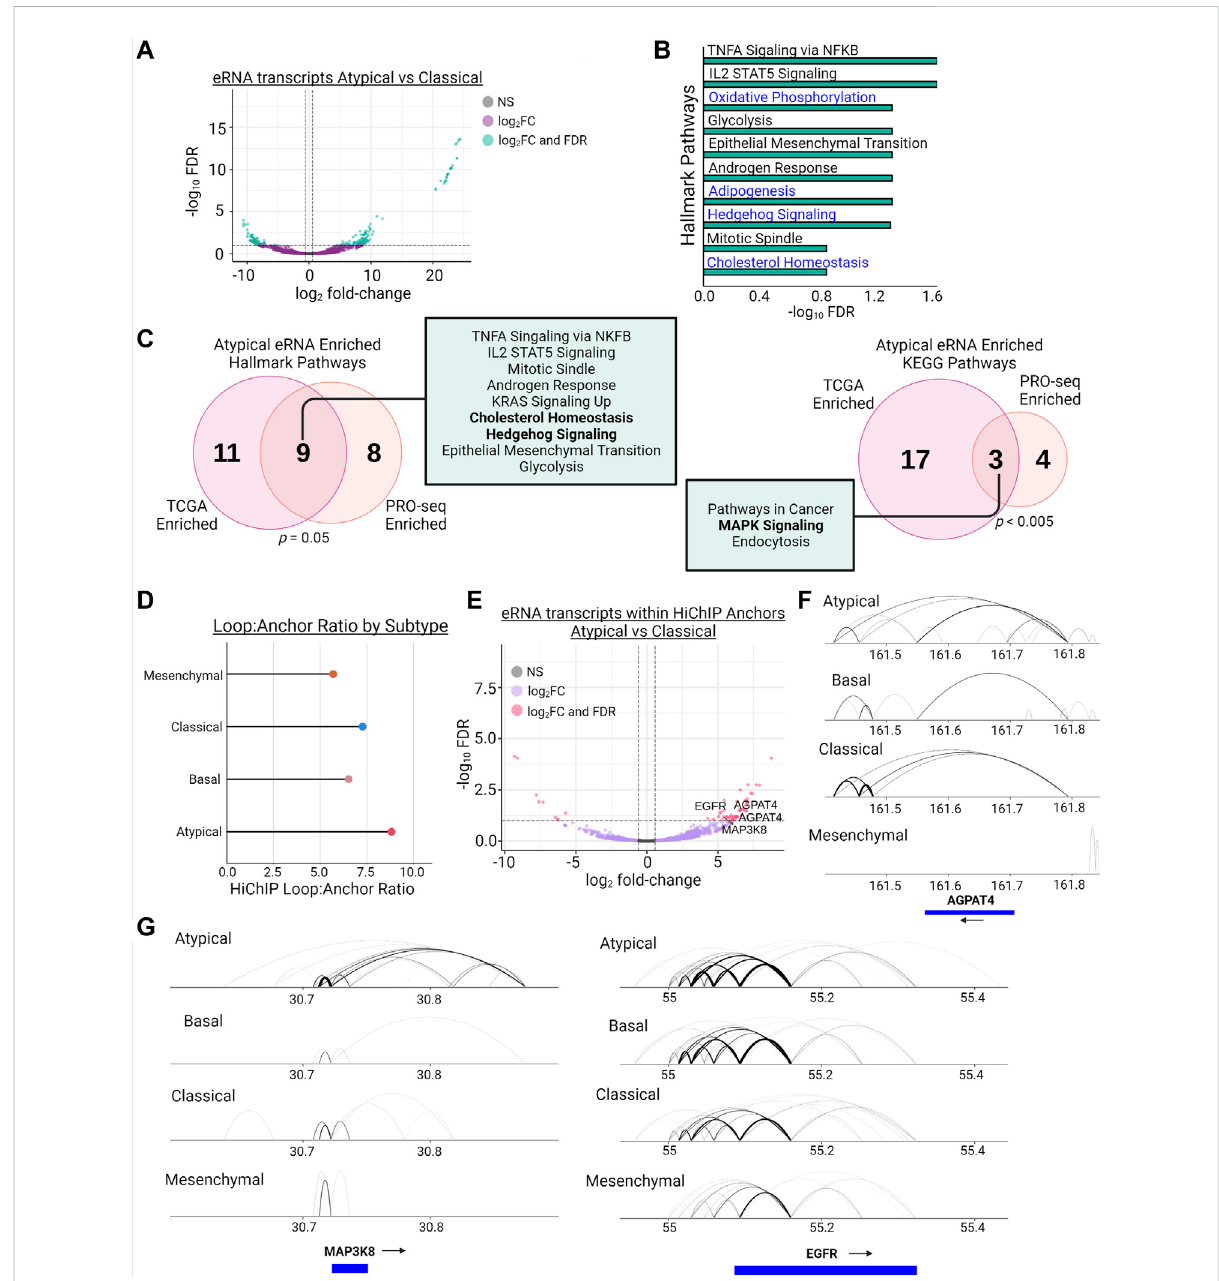
FIGURE 4 Enhancers of MAPK signaling, WNT signaling, and Cholesterol Homeostasis genes display increased eRNA transcription and enhancer- promoter looping in Atypical HNSCC. (A) Differential transcription (|log 2 fold-change| > 1.5 & FDR < 0.1) of eRNAs between the Atypical and Classical subtypes as measured by PRO-seq (green dots meet fold-change and FDR thresholds, purple dots meet fold-change threshold only). (B) Hallmark pathwayenrichmentanalysisofgeneslinkedtoeRNAswithsigni fi cantlyincreasedtranscriptionfrom (A) ;pathwaysinbluehavebeenpreviously associated with BET inhibitor resistance. (C) Overlap of hallmark (left) and KEGG (right) pathway enrichment results between PRO-seq-determined signi fi cantly enriched eRNAs from (A) and (B) and TCGA-measured differentially expressed eRNAs between Atypical and non-Atypical samples; p valuesrepresenthypergeometrictestsofgenesetenrichmentresultoverlaps;boldedtermsrepresentsharedpathwaysassociatedwithBETinhibitor resistance. (D) Lollipop plot demonstrating the loop count:anchor count ratio of H3K27ac HiChIP data for each molecular subtype. (E) Volcano plot of differentially transcribed (|log 2 fold-change| > 1.5 & FDR < 0.1) eRNAs between the Atypical and Classical subtypes after fi ltering transcripts for only thosecontainedwithinH3K27acHiChIPanchors(pinkdotsmeetfold-changeandFDRthresholds,purpledotsmeetfold-changethresholdonly). (F) Joined Hallmark and KEGG pathway enrichment analysis of genes linked to differentially transcribed eRNAs in (E) ; pathways in blue have been previously associated with BET inhibitor resistance. (G) Visualization of H3K27ac HiChIP loops at the MAP3K8 locus (left) and EGFR locus (right) in all 4 HNSCC molecular